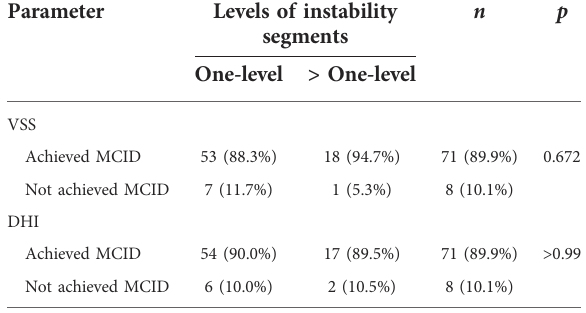
TABLE 5 Patient-reported outcomes during follow-up terms ( n =79).